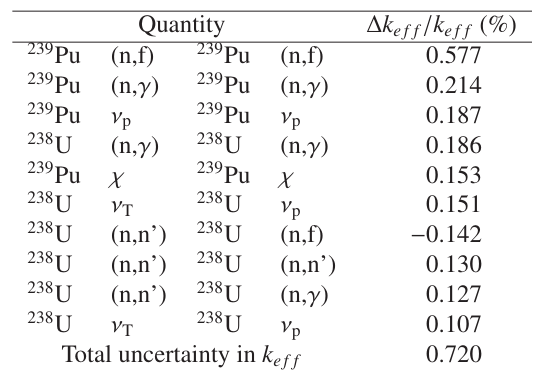
Table 2. k ef f uncertainty quantification for ALFRED with ENDF / B-VIII.0.